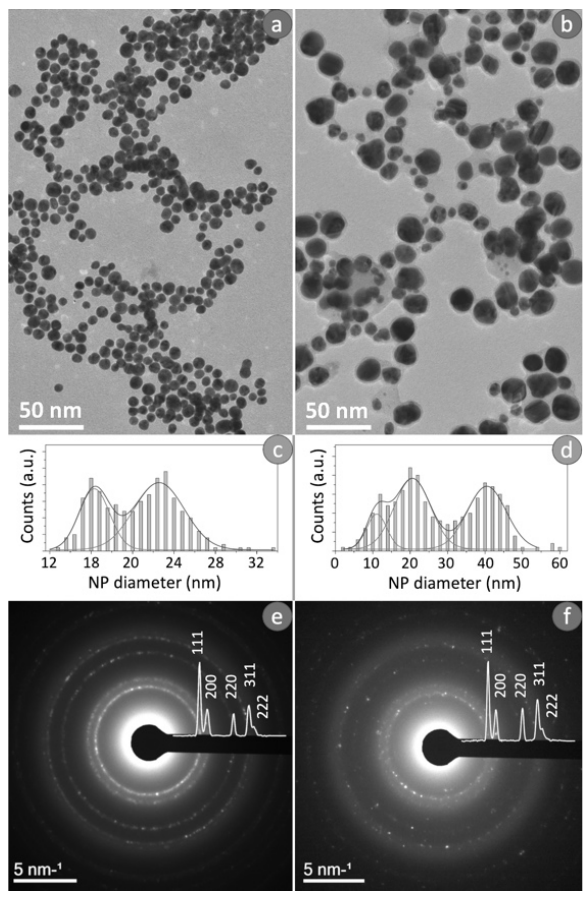
Figure 1. Typical bright field TEM images obtained from conventional Ag NPs ( a ), related size distribution ( c ) and SAED pattern ( e ). Typical bright field TEM image recorded from green Ag NPs ( b ), related size distribution ( d ) and SAED pattern ( f ).